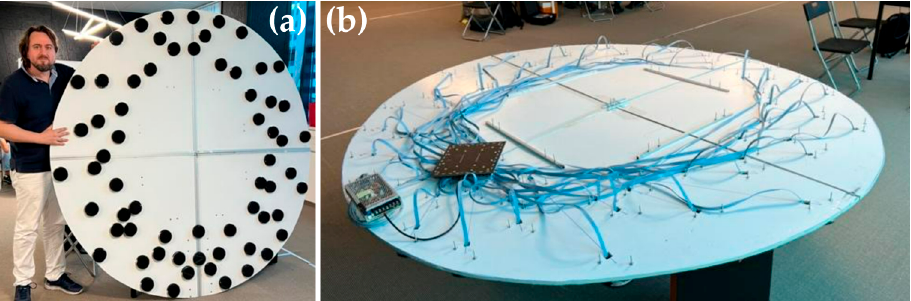
Figure 9. AC mounted on a cardboard circle for testing purposes: ( a ) front side with microphones; ( b ) back side with central board and a test power supply.